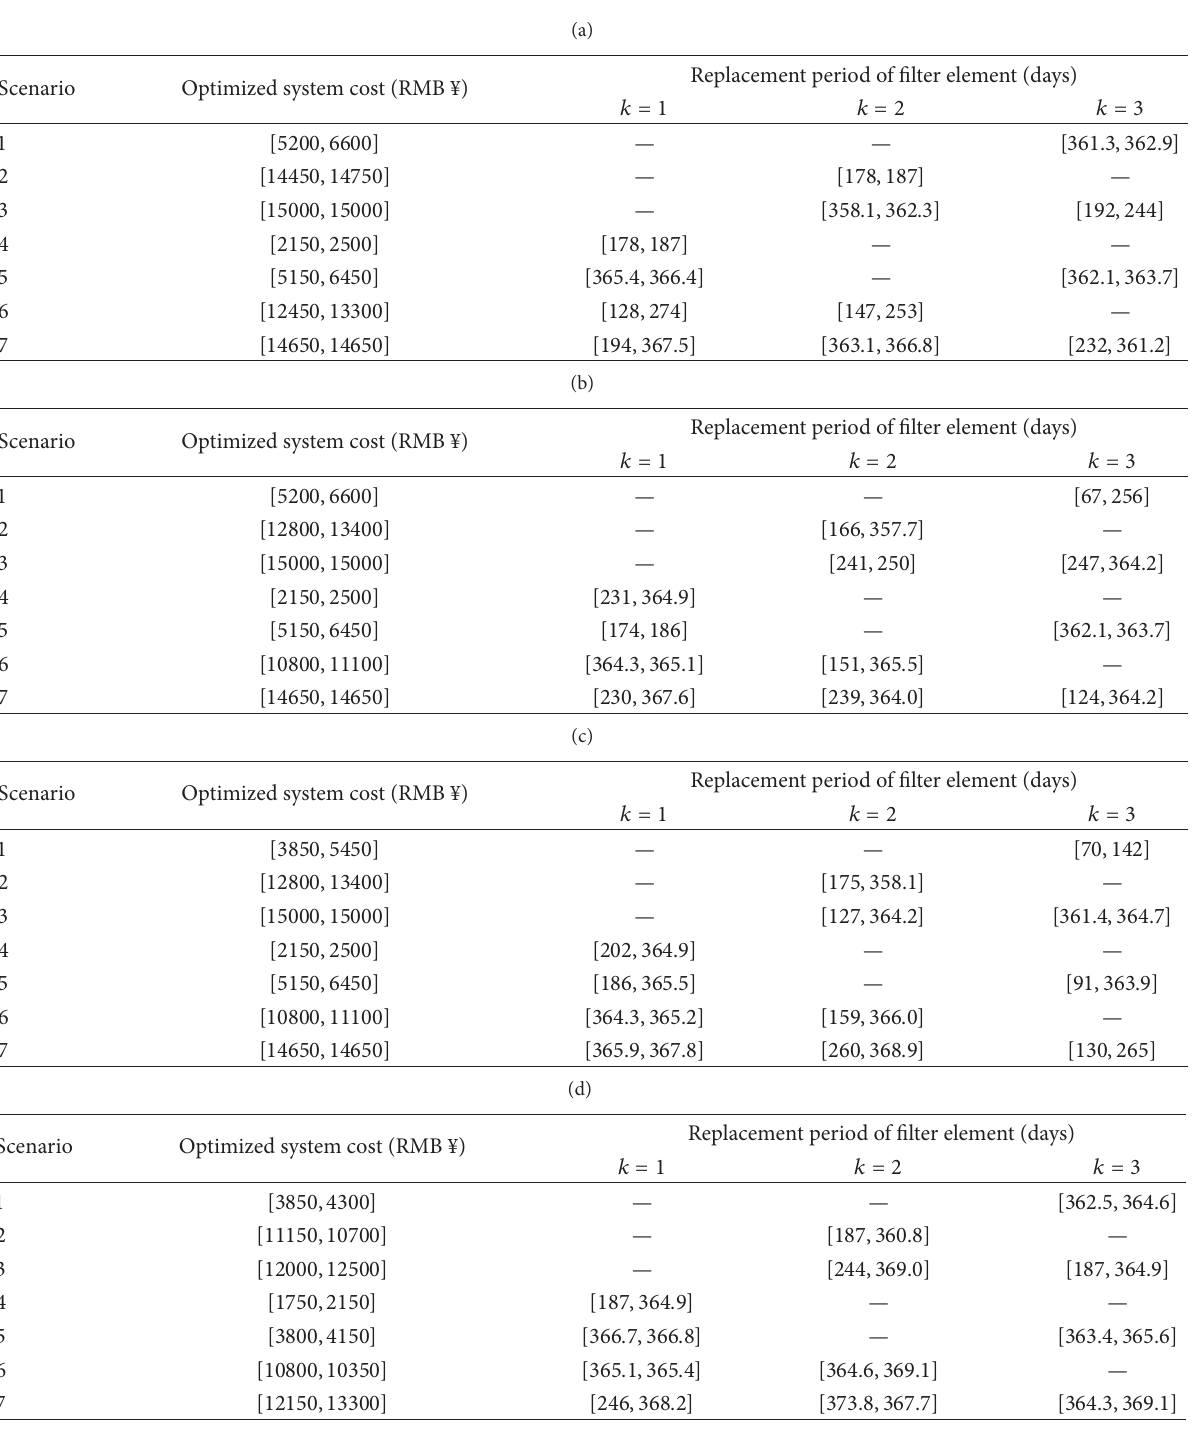
Table 7: (a) Results for optimized system cost and filter-replacement period under medium ingression/generation rate (8 hours per day) (when 𝑝 1 = 0.10 ). (b) Results for optimized system cost and filter-replacement period under medium ingression/generation rate (8 hours per day) (when 𝑝 2 = 0.15 ). (c) Results for optimized system cost and filter-replacement period under medium ingression/generation rate (8 hours per day) (when 𝑝 3 = 0.20 ). (d) Results for optimized system cost and filter-replacement period under medium ingression/generation rate (8 hours per day) (when 𝑝 4 = 0.30